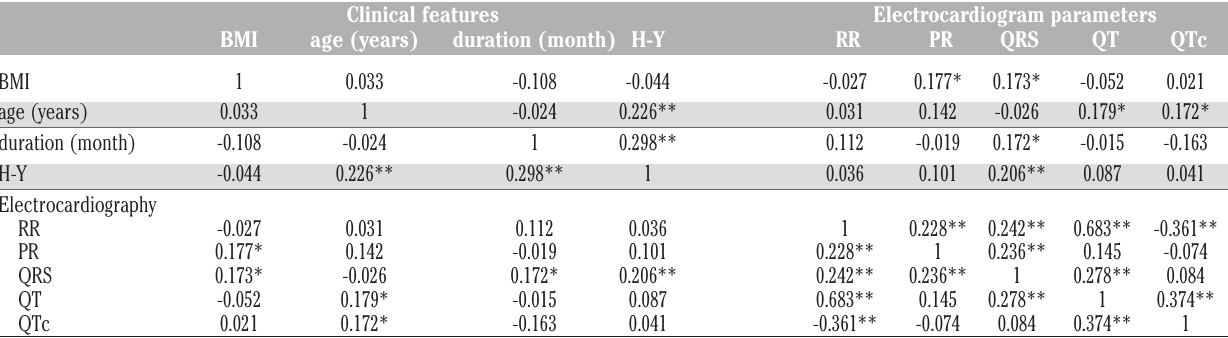
Table 1. Correlations between clinical features and electrocardiogram parameters. Clinical features